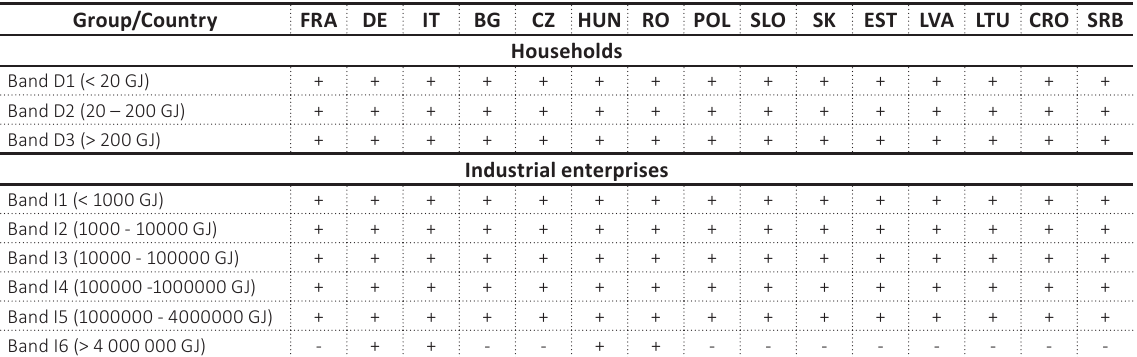
Table 1. Groups of natural gas